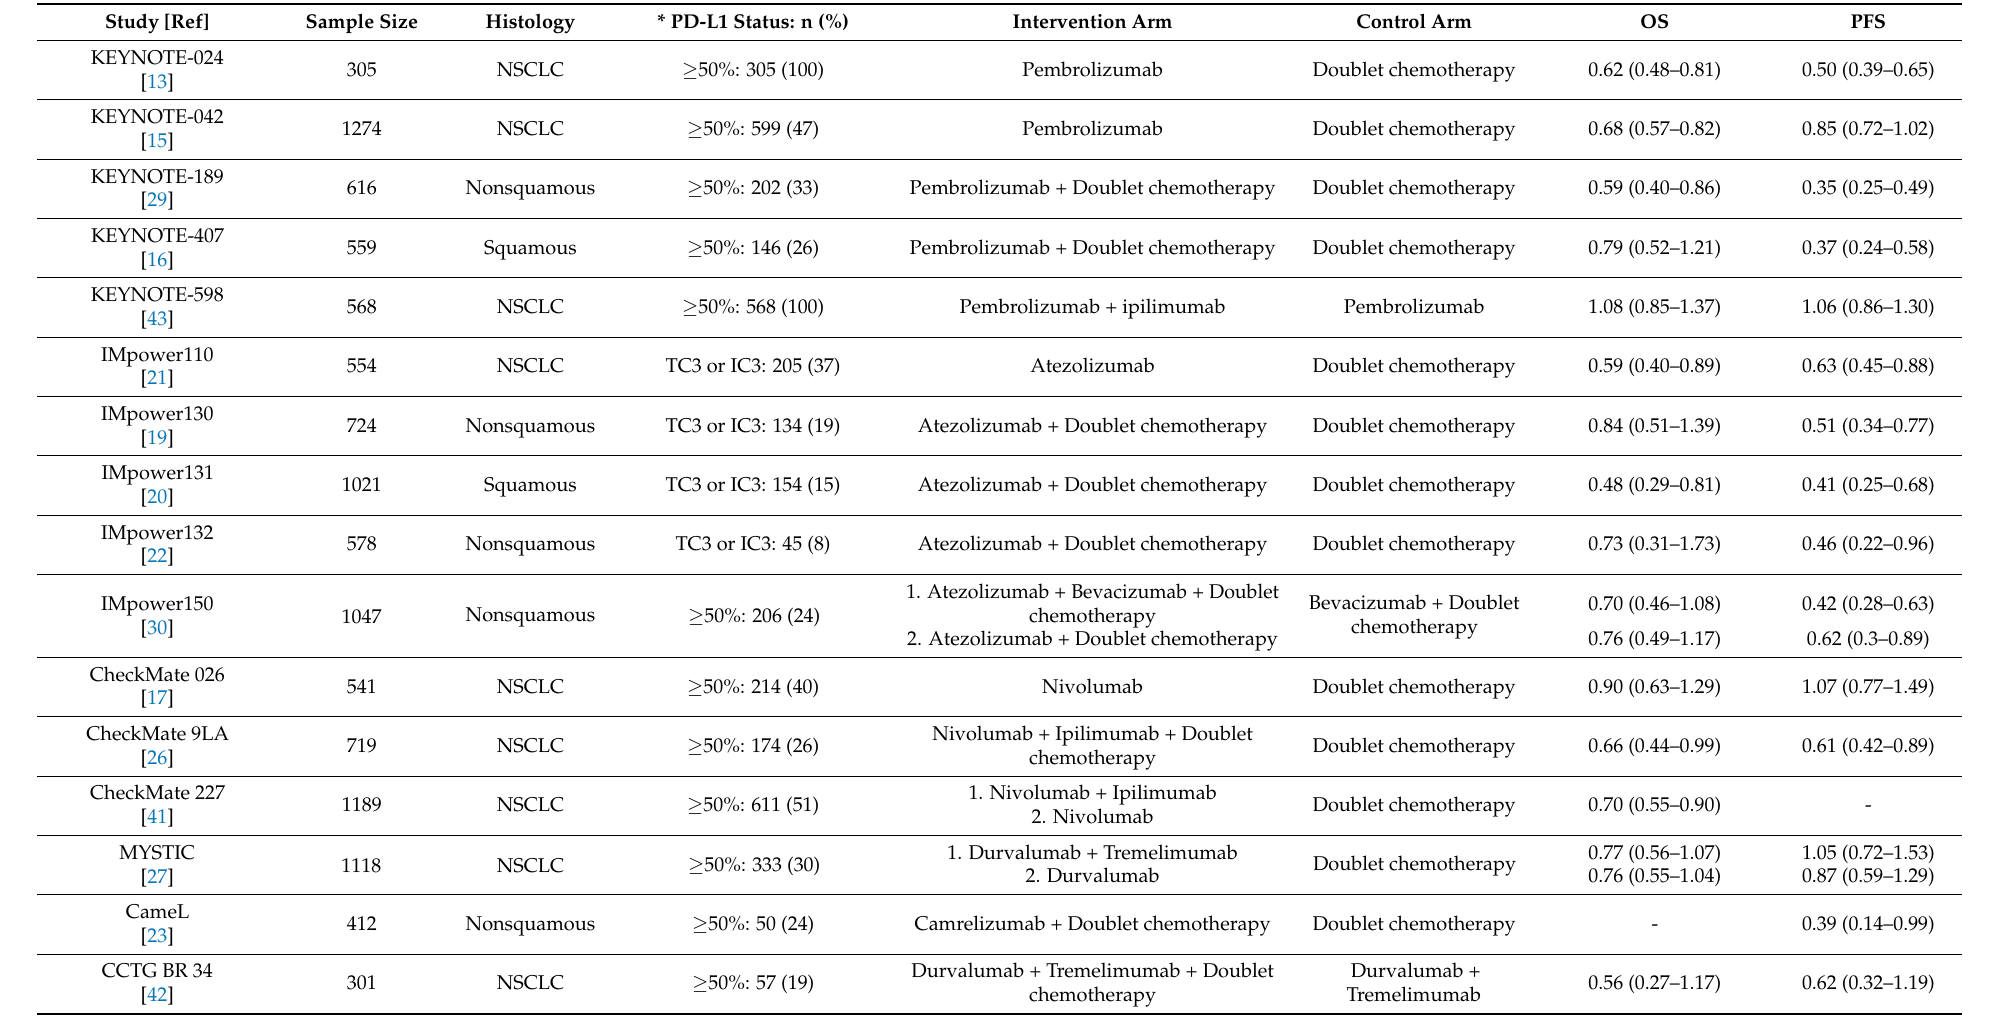
Table 1. Main characteristics of the 22 studies included in the Bayesian network